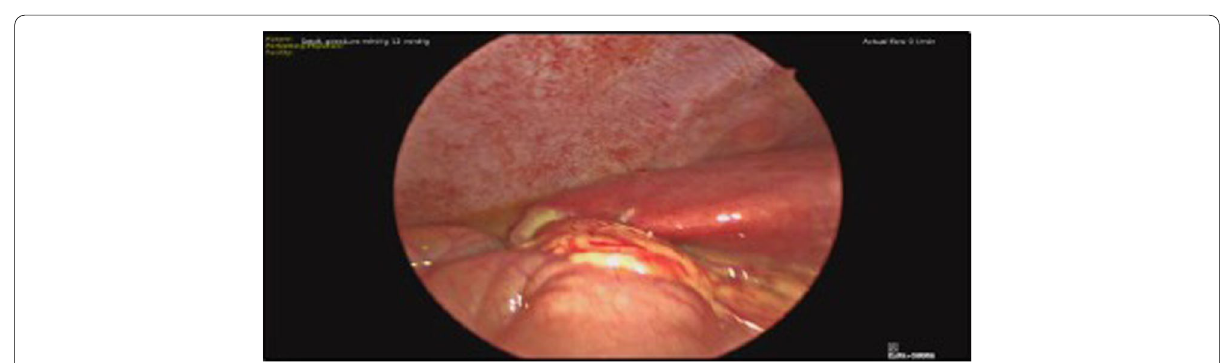
Fig. 2 Laparoscopic image of right upper quadrant demonstrating adherent omentum overlying the